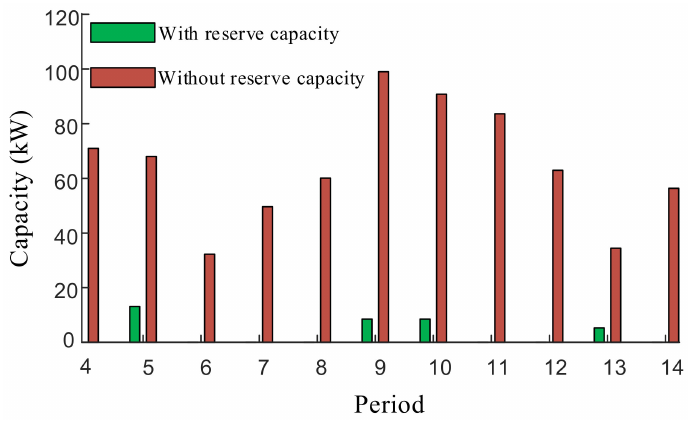
Figure 4. The capacity deviation value under two bidding strategies. Table 1. The income and cost under the two bidding strategies. With or without Reserve